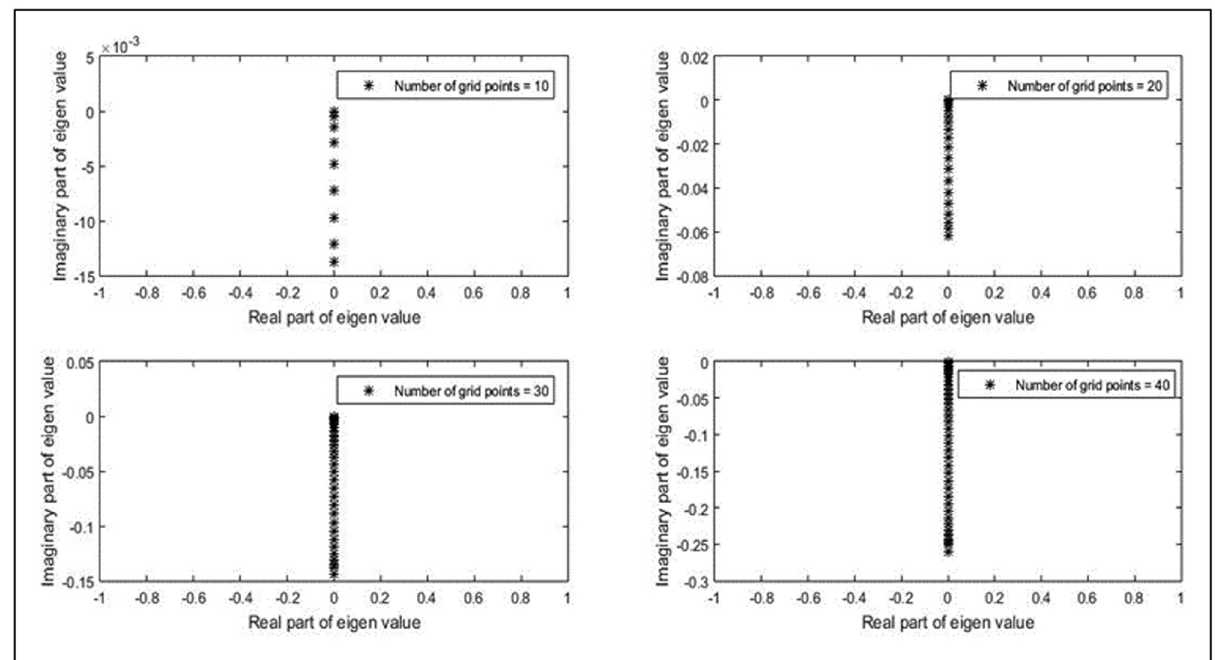
Figure 21: The stability of the present method in two dimension at di ff erent number of grid